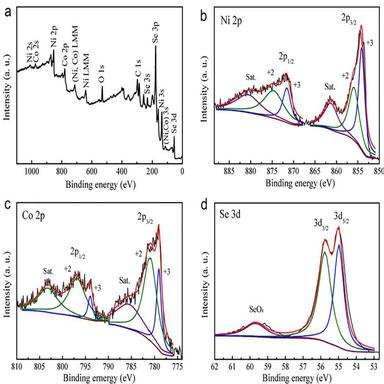
XPS spectra of the Ni0.67Co0.33Se2: (a) wide-scan survey spectrum and high-resolution (b) Ni 2p, (c) Co 2p and (d) Se 3d spectra.